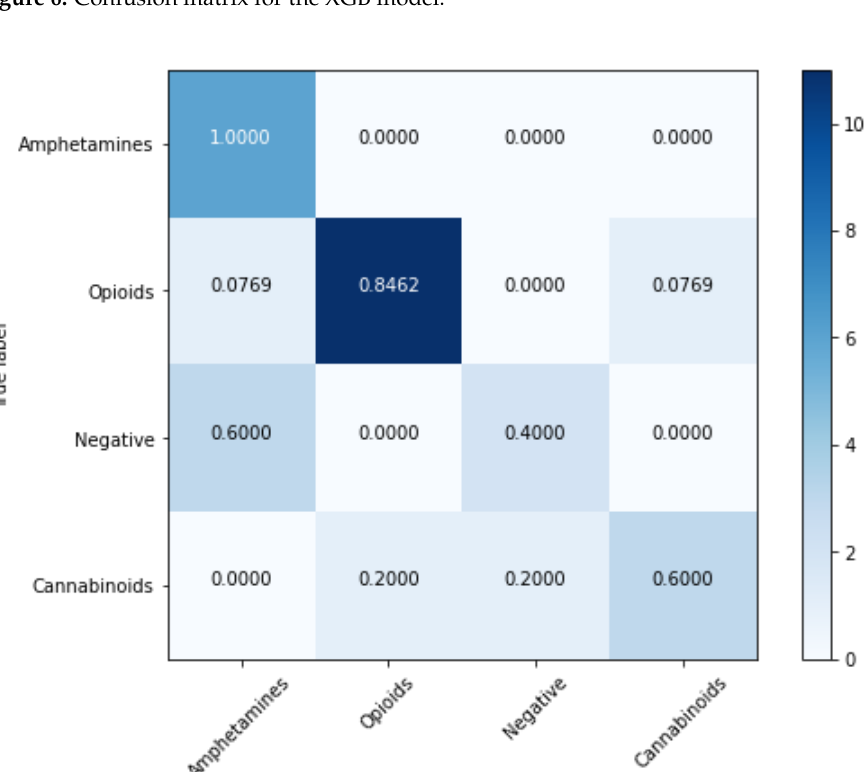
Figure 7. Confusion matrix for the Random Forest model.